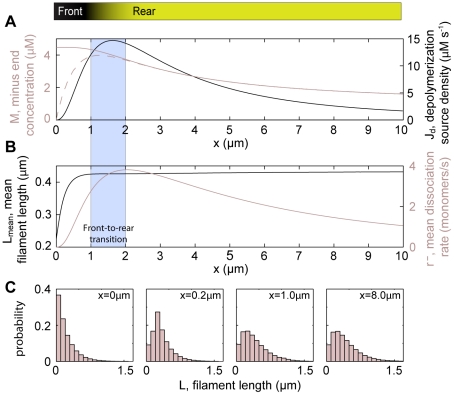
Model solutions describing essential lamellipodium (“front”) and lamellum (“rear”) characteristics.These characteristics are a local maximum of the depolymerization source density Jd at the transition between front and rear (A) and a distinctive filament length distribution Lmean with its steep gradient within the front and a plateau in the rear (B). (C) Filament length histograms at different distances from the leading edge illustrate the emergence of the mean filament length distribution in (B). The dashed light line in (A) represents the debranched fraction of all (solid light line) minus-ends. r
− in (B) is the ensemble-averaged rate of subunit loss from a filament minus-end at position x.